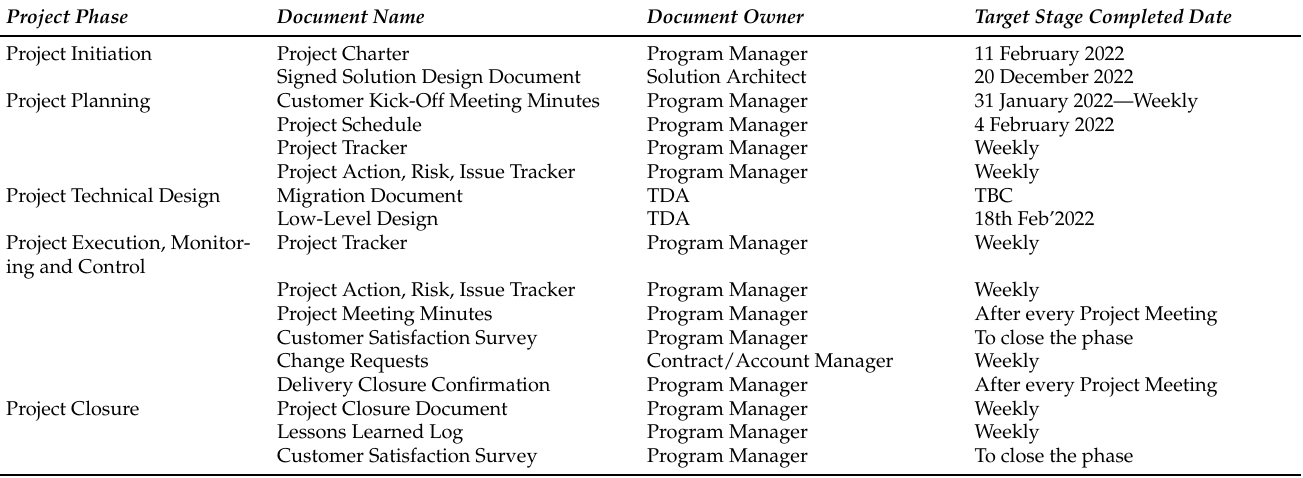
Table 8. Project